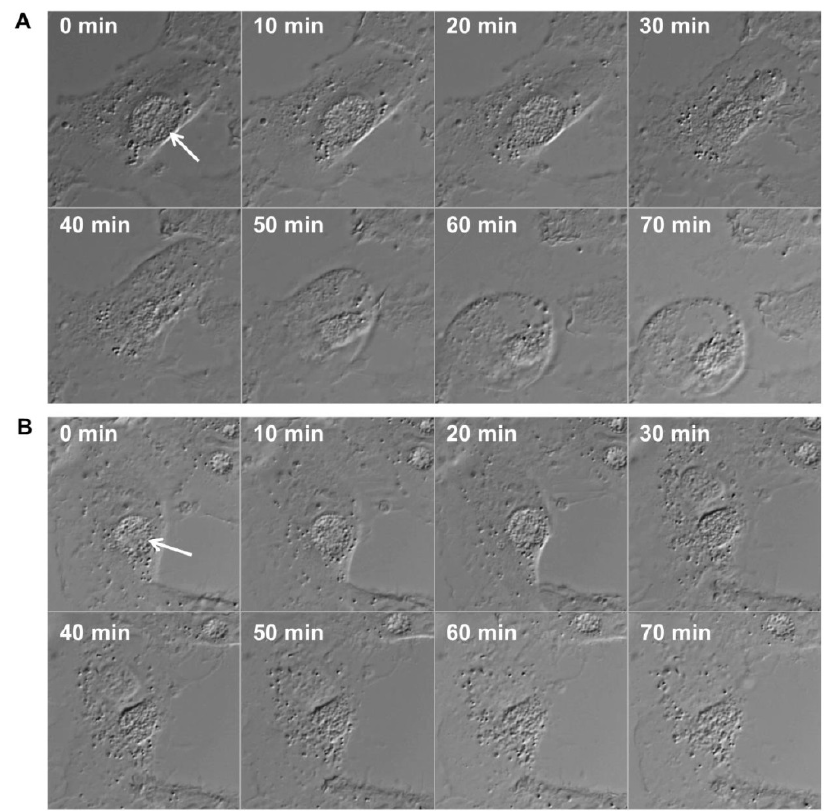
FIGURE 2: Time lapse microscopic image series displaying inclusion and plasma membrane rupture in HeLa cells infected with CpoS-deficient C. trachomatis . HeLa cells (ATCC CCL-2) were infected with CpoS-deficient C. trachomatis L2/434/Bu (CTL2- cpoS :: bla, 10 inclusion-forming units/cell) and imaged for over 40 hours in 10-min intervals at an Axio Observer.Z1 series (A and B) document the process of